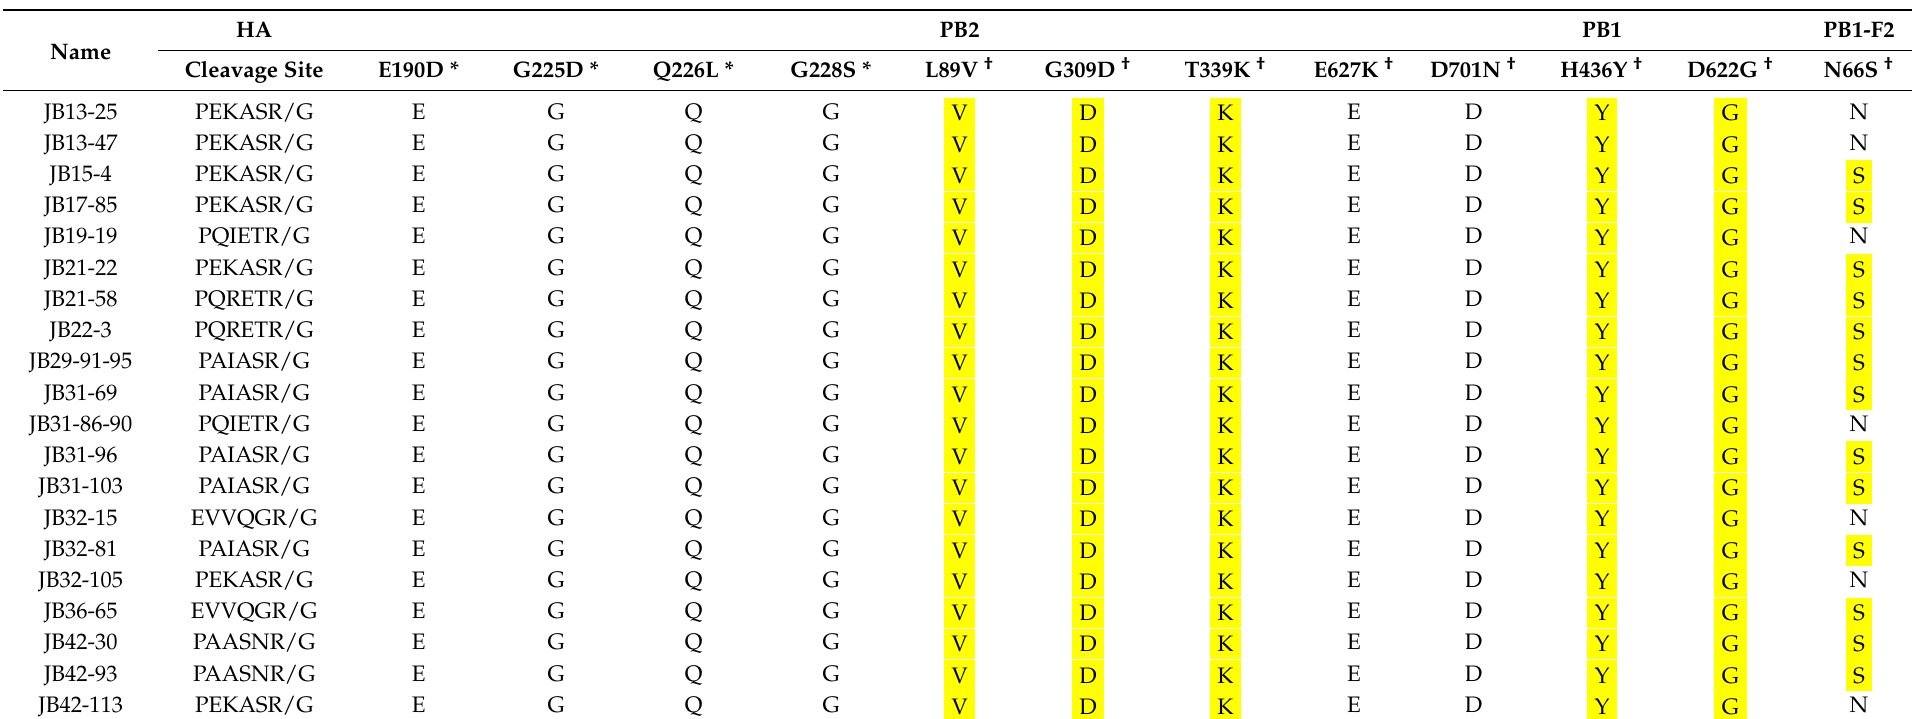
Table 4. Amino-acid sequences and mutations in avian influenza viruses (AIVs) isolated from wild birds in South Korea between 2019 and 2020. The sequences in which amino acid substitutions were identified are shown in yellow. * HA receptor binding site (RBS) related with binding specificity. † Amino acid mutations related to increased virulence in mammalian cells and mice. § Amino acid mutations related to drug